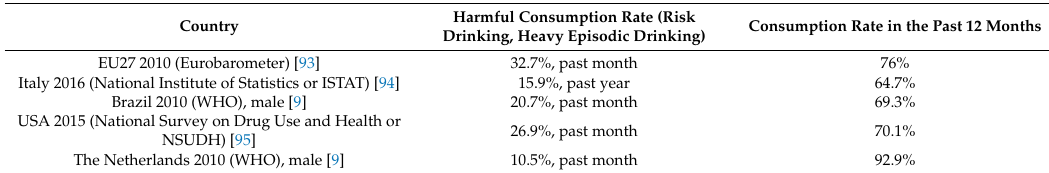
Table 9. Alcohol consumption in the general population 15+ years